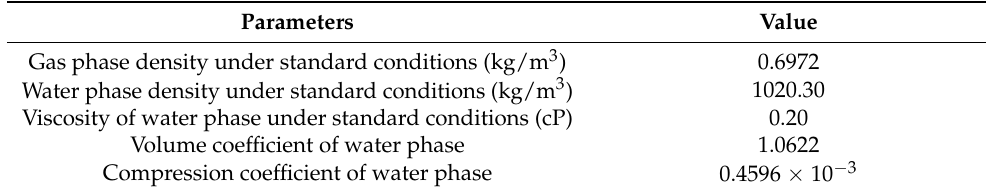
Figure 9. Schematic of fracture grid and matrix grid conduction patterns. The change in stress during the development of the gas reservoirs was simulated, without considering the influence of temperature change and capillary force. The target formation is a high-temperature and high-pressure gas reservoir; the initial formation pressure gradient is about 1.8 MPa/100 m, and the converted reservoir pore pressure is about 120 MPa~123 MPa. The water production is small and can be considered as no edge and bottom water. The gas-water interface is set at about 7000 m in the simulation, below the main force level. The rest of parameters are shown in Table 2. Table 2. The parameters of the seepage numerical model for the target formation.